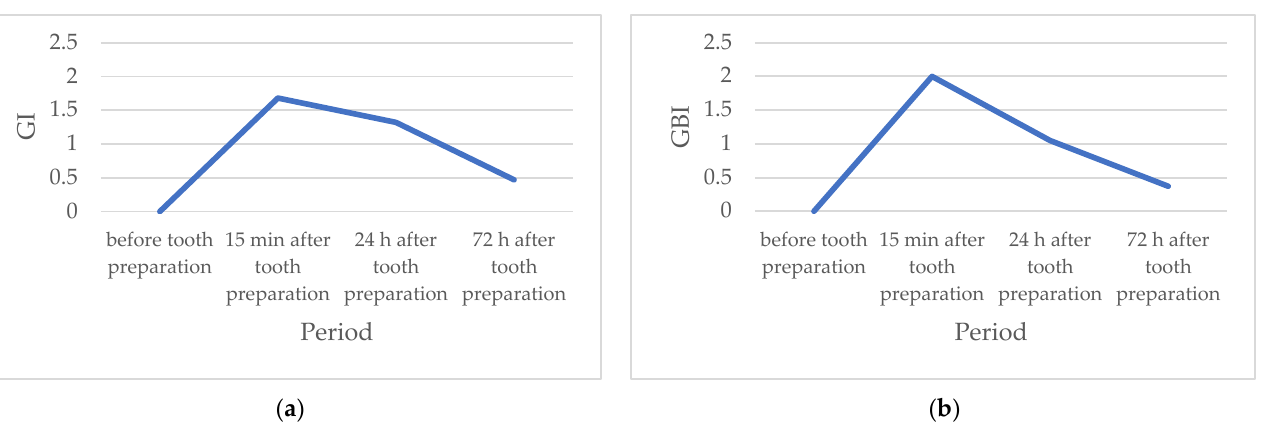
Table 2. Cytological values during the study.